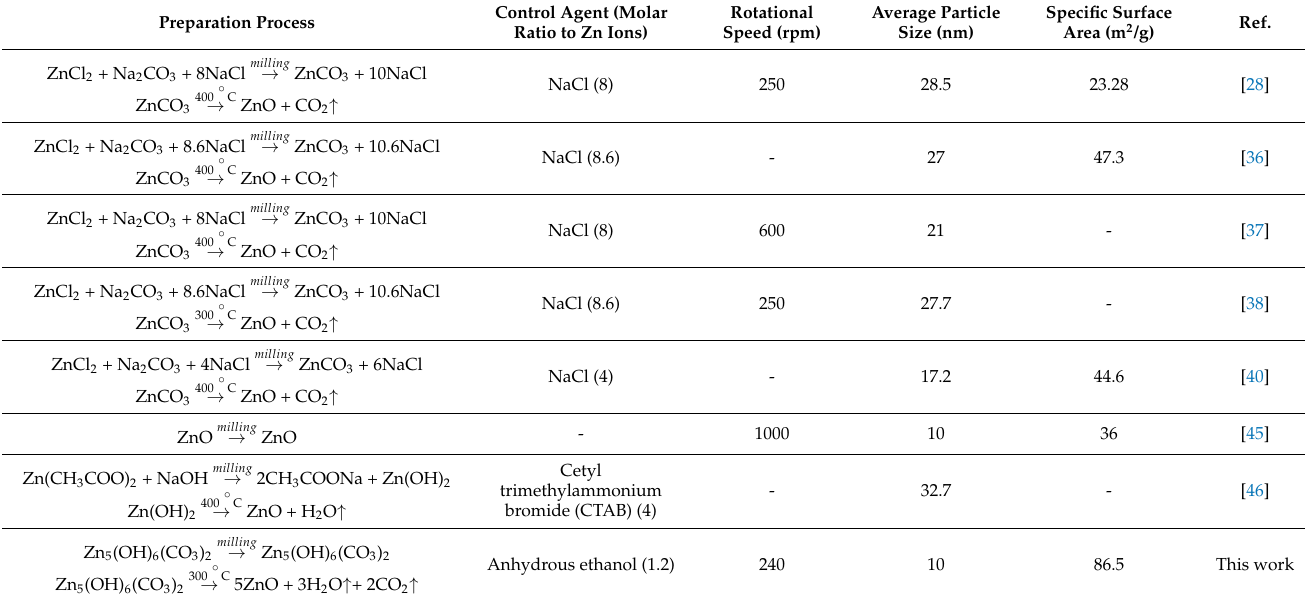
Table 2. Some published literature on the mechanochemical synthesis efforts in terms of the control agent used, average par- ticle sizes, and specific surface areas.